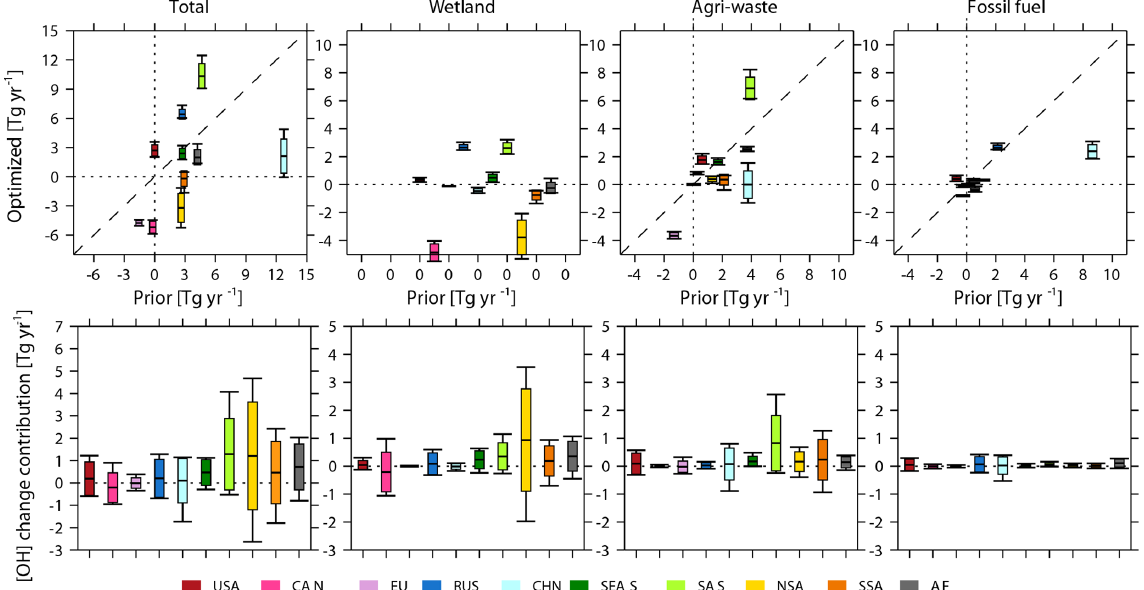
Figure 7. Top: optimized global total and sectoral regional emission changes (Tgyr − 1 ) from the early 2000s to the late 2000s ( y axis) plotted against prior emission changes between the two time periods ( x axis) as derived from Inv2 and Inv3. The prior wetland emissions are constant over time and thus show zero changes (all “0” on the x axis). Bottom: contribution of OH changes between the two periods to top-down estimated emission changes (Inv3-Inv4). The box plots (defined by Fig. 1) show the standard deviations and ranges calculated with different OH